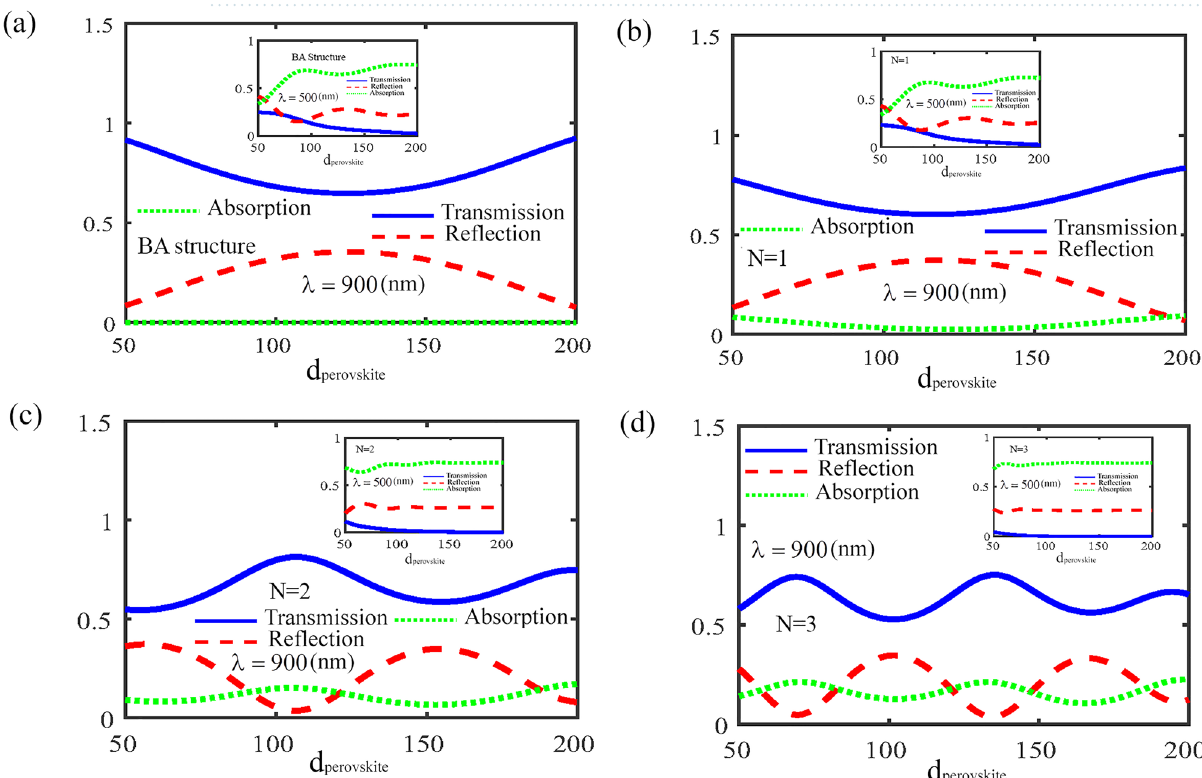
Figure 4. The dependence of the absorbance, transmittance and reflectance coefficients on the thickness of the